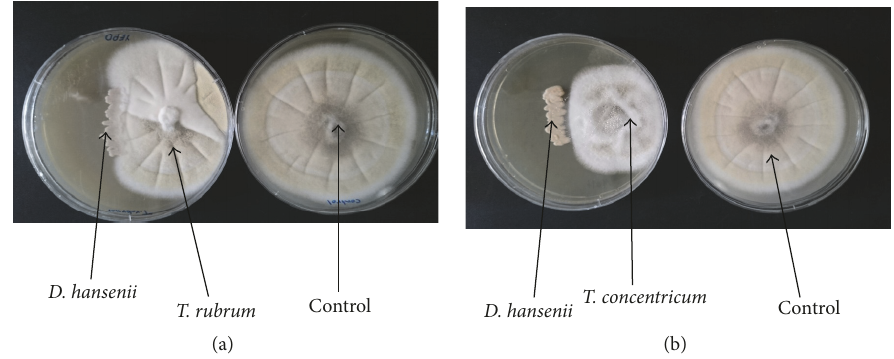
Figure 5: The antagonistic activity of D. hansenii in vitro . The ability of D. hansenii to decrease the growth of T. rubrum (a) and T. concentricum (b) was examined. D. hansenii was streaked out and either T. rubrum or T. concentrcum was inoculated on the same plate. As a control both T. rubrum and T. concentricum were inoculated separately without D. hansenii . All plates were incubated at 28 ∘ C for 7 days. All strains were indicated by black arrows.